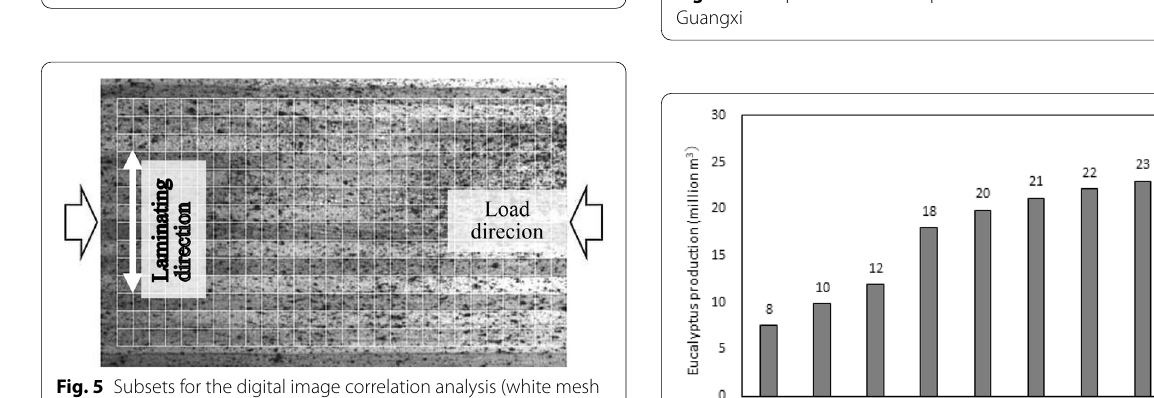
Fig. 4 Set-up for the compression test